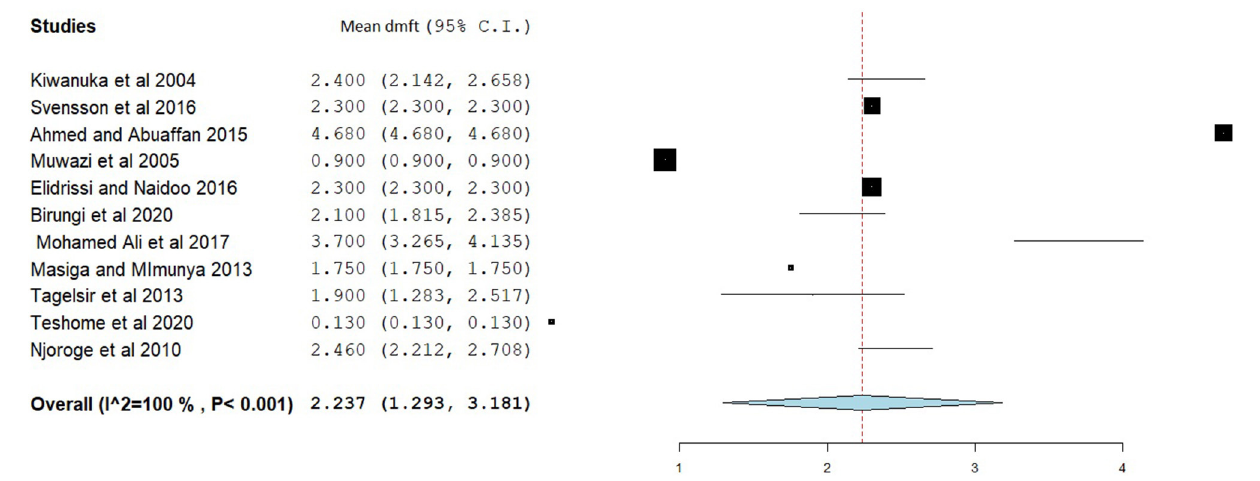
FIGURE 9 | Forest plot showing the mean dmft in East Africa.